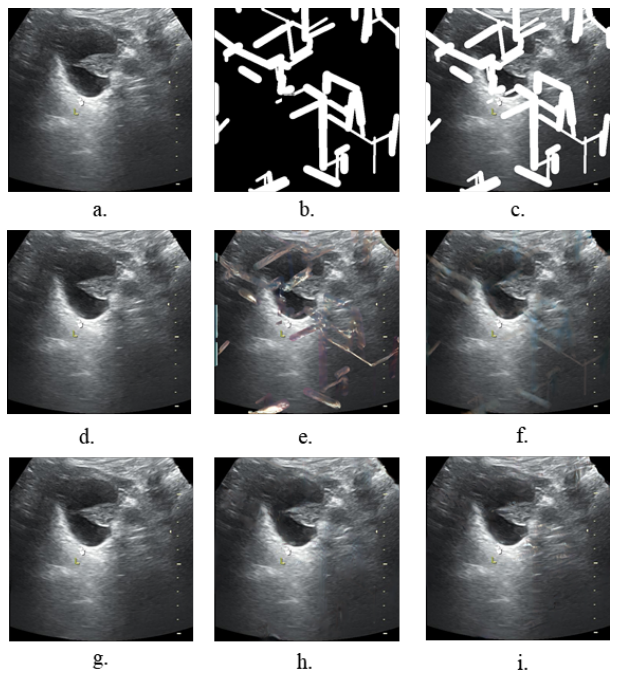
Figure A3. Comparison between the results of our proposed model and those of other models. ( a ) The ground truth image. ( b ) The mask for the ground truth image. ( c ) The masked image. ( d ) LaMa